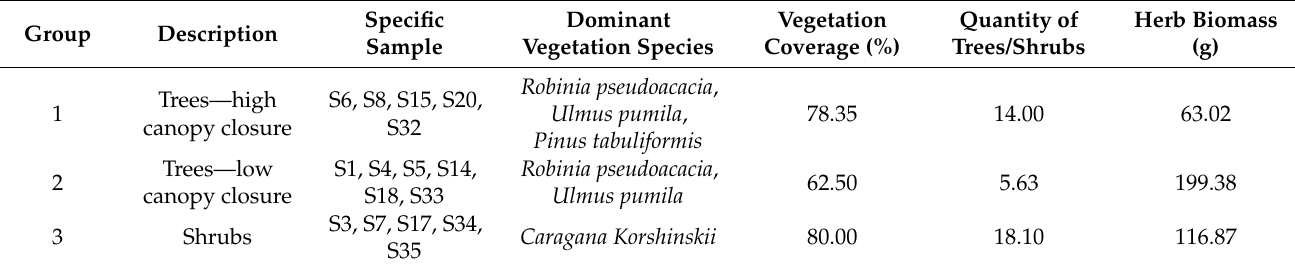
Table 3. Grouping of sample points in the study area.